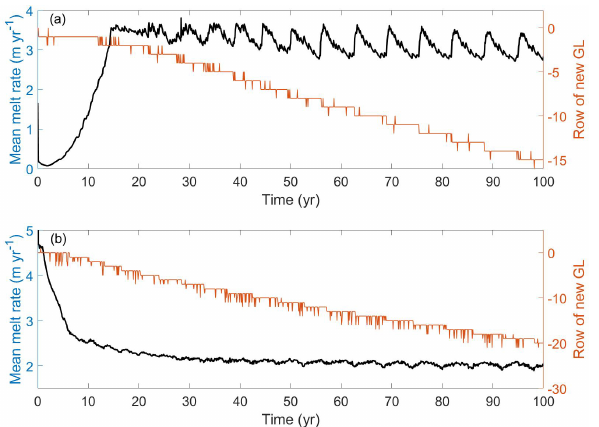
Figure A7. Simulated mean melt rates with different tracer proper- ties for the nudging dry cells.